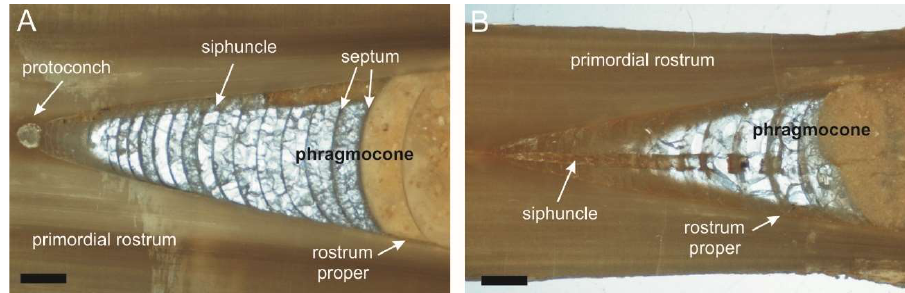
Figure 4. Examples of Oxfordian belemnites ( A , specimen PC-11-183; B , specimen PC-11-31)